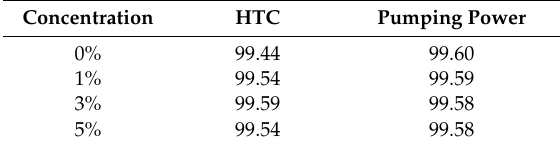
Table 8. The percentage of the adjusted coe ffi cient of determination for each